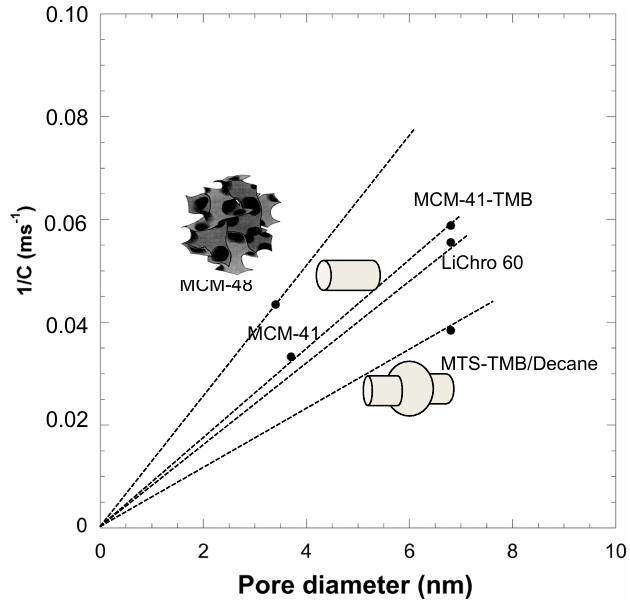
Figure 4. Inverse of C parameter of Van Deemter equation (1/C) as a function of mesopore size (diameter for cylindrical pores, cavity size for spherical pores) for different mesoporous silica materials of 10 microns particles size. C values calculated for diethylphtalate in dioxane/heptane mobile phase [20].